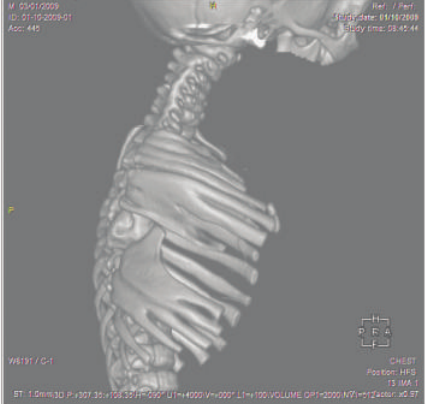
Figure 4: Three-dimensional CT scan lateral thoracic image de- monstrating many rib points of fusion originated